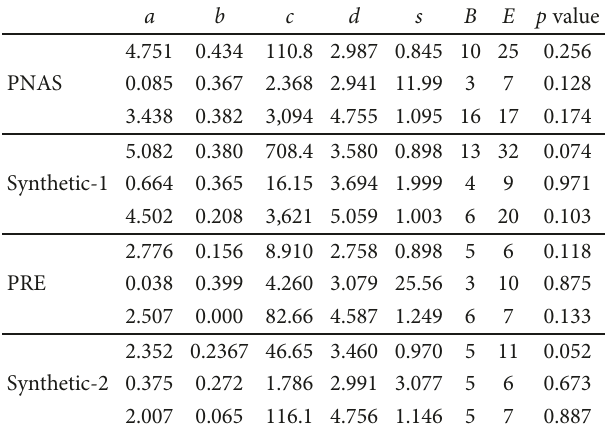
Table 5: The parameters and goodness of fi tting functions for degree distribution, hyperdegree distribution, and the distribution of paper team sizes, from top to